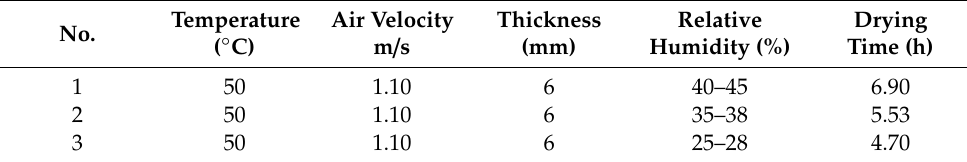
Table 9. E ff ect of air relative humidity on the drying